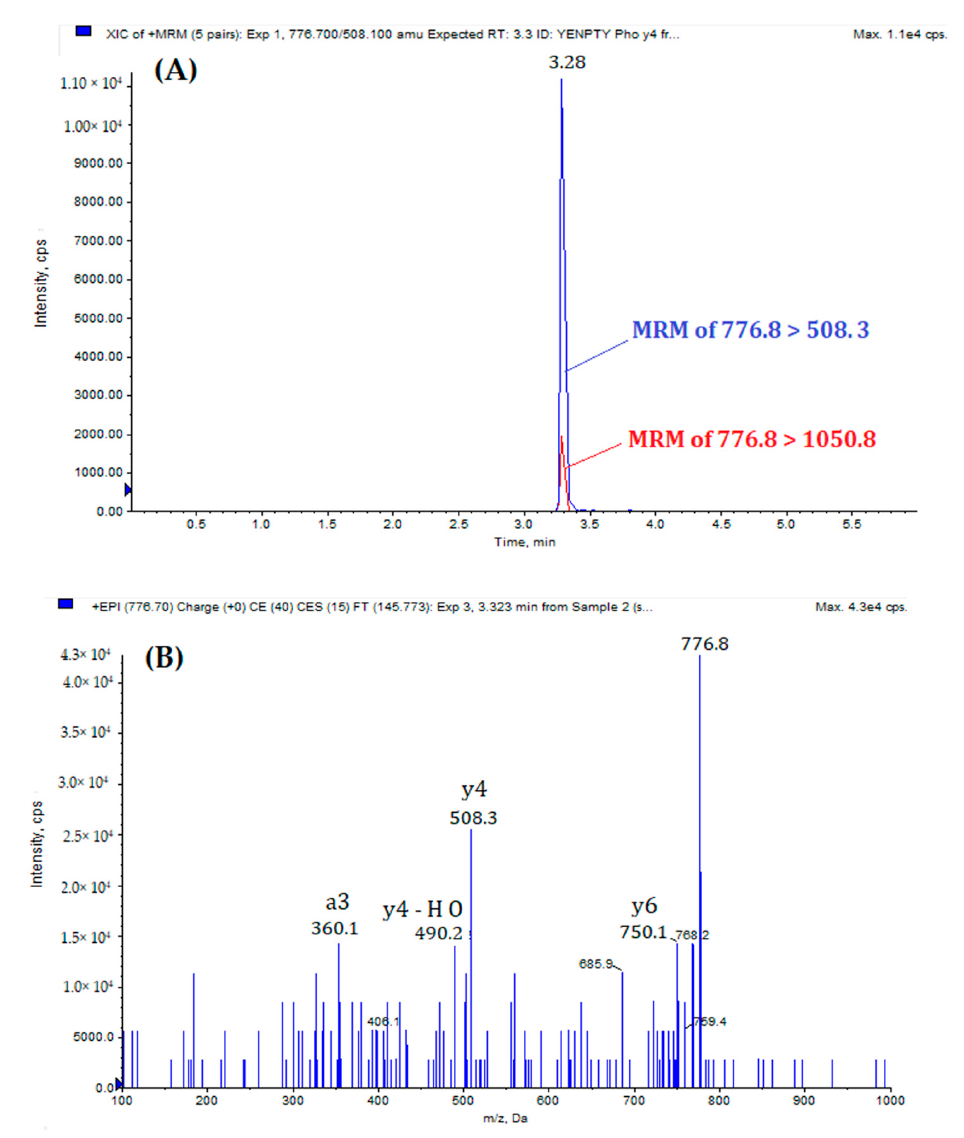
Figure 2. ( A ) Extract ion chromatogram of MQQNGYpENPTYK: MRM transition 776.8 > 508.3 (blue) and 776.8 > 1050.8 (red). ( B ) EPI spectrum of MQQNGYpENPTYK. Calibration curves, correlation coefficient (r), imprecision, inaccuracy, and LOD and LOQ values for The validation was obtained by analyzing calibration curves and quality controls. MQQNGYENPTYK and MQQNGpYENPTYK quantification. The linearity of calibration curves for both peptides, MQQNGYENPTYK and MQQNGYpENPTYK, was estimated by the coefficients of correlation (r) which were re- spectively 0.9972 and 0.9984. The slopes were 0.30970 and 1.05976 and intercept values were − 0.00604 to − 0.00309 (Table 2).